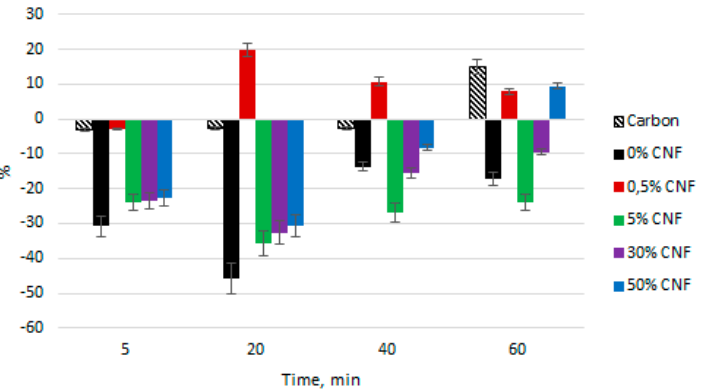
Figure 3. The change in time of the optical density of blood plasma upon contact of blood with sorbents in vitro at a wavelength of 414 nm.